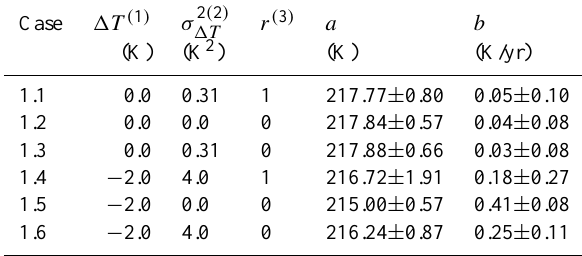
Table 1. Case Study 1.